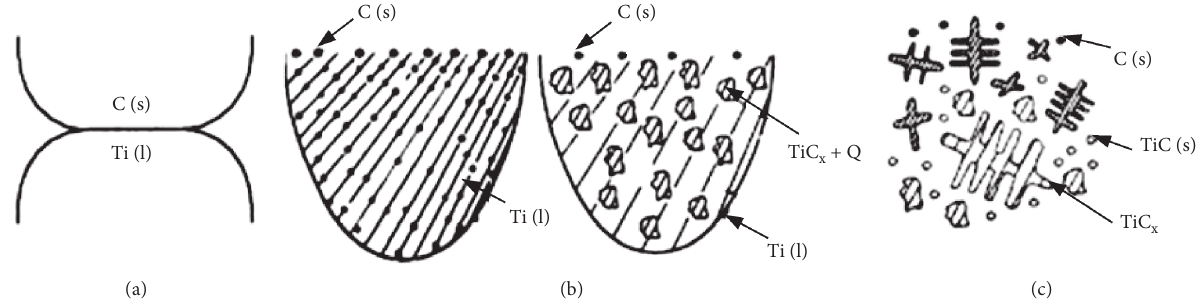
x ; (c) the liquid Ti